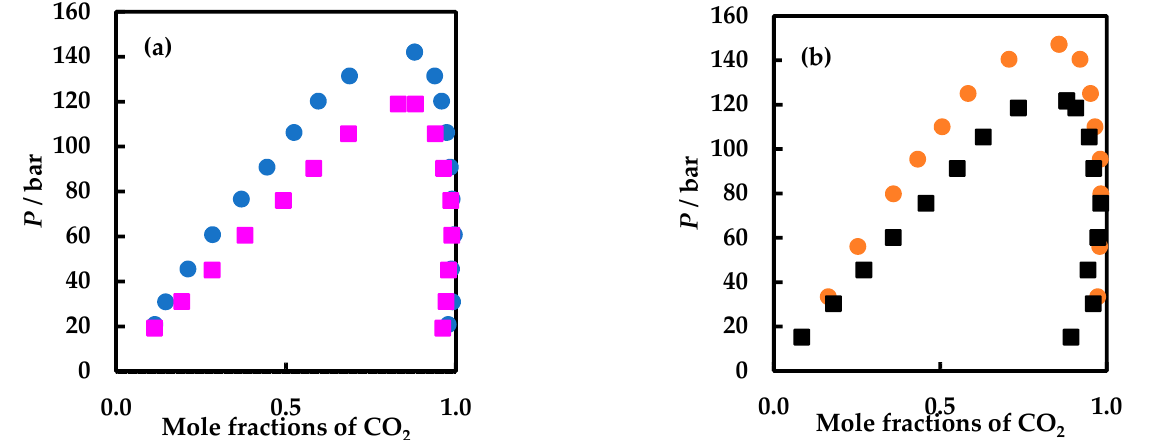
Figure 2. Comparison of measured and literature data for carbon dioxide (1) + 1-butanol (2), + 2- butanol (2), + isobutanol (2), and + tert -butanol (2) binary systems at 365.15 K. CO 2 + 1-butanol : ◆ , [47]; CO 2 + 2-butanol: ▲ [47]; CO 2 + isobutanol:  this work; CO 2 + tert -butanol:  , this work.